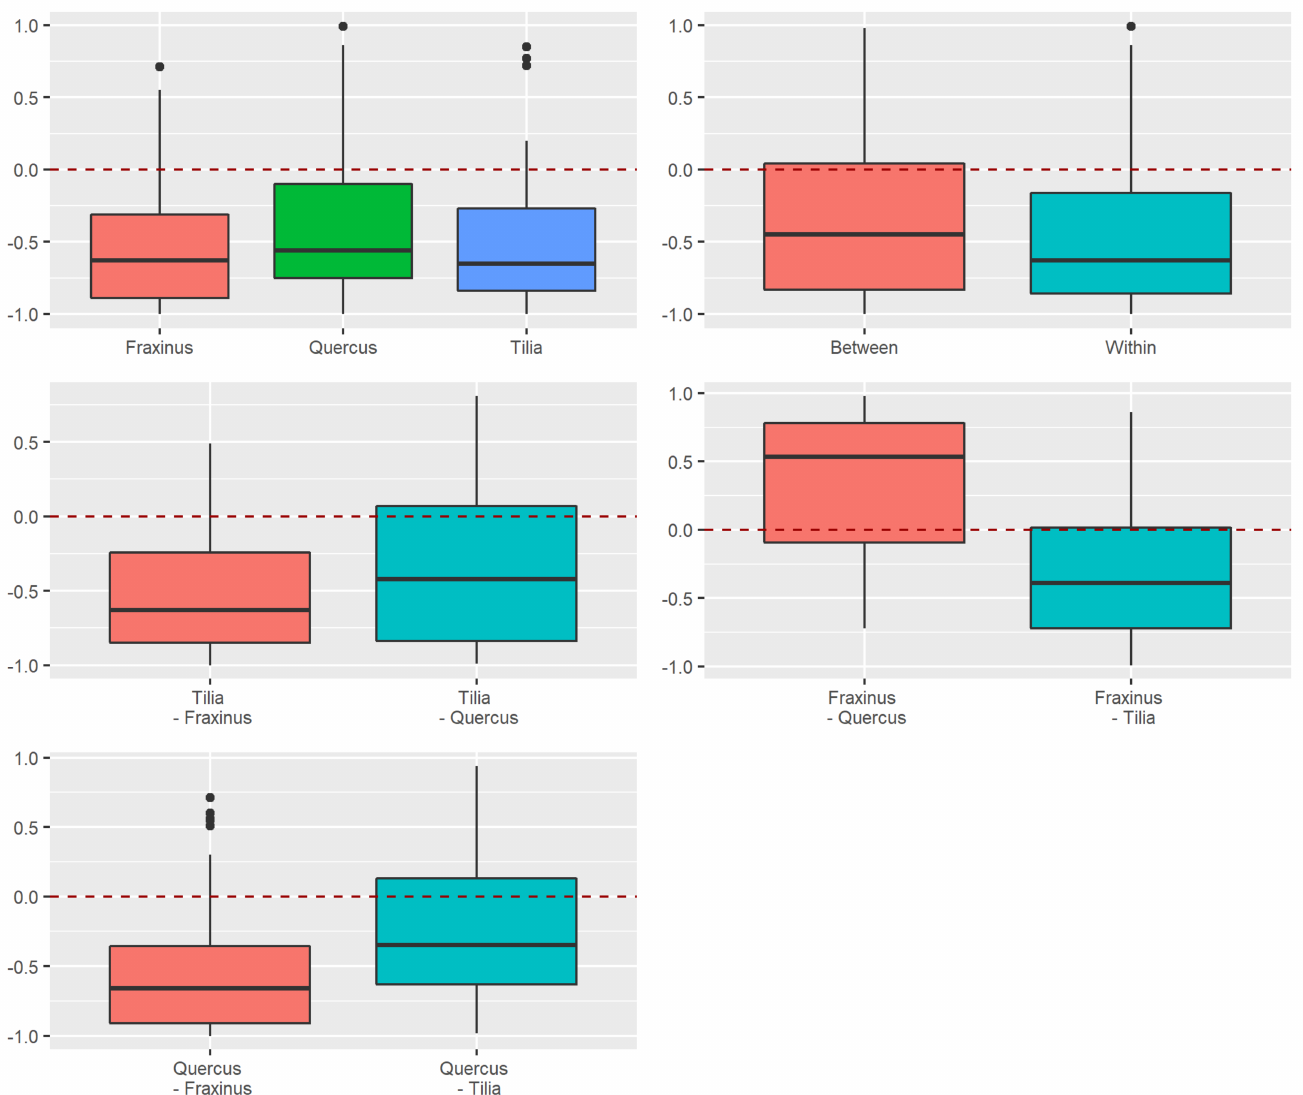
Figure A5. Deviation of the beta diversity from the diversity expected by the null hypothesis per tree species for the rare beetle species. Comparisons within a tree species are comparisons of two traps of the same tree species. Comparisons between tree species are comparisons of two traps from two different tree